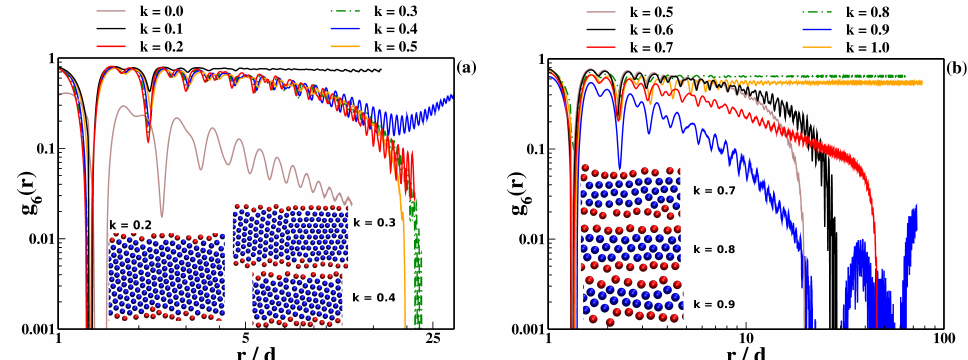
Figure 3. Orientational correlation function, g 6 ( r ) , in the intervals ( a ) 0 ≤ k ≤ 0.5 and ( b ) 0.5 ≤ k ≤ 1.0, where one can easily distinguish between particles belonging to the boundary (red) and those confined to a certain region